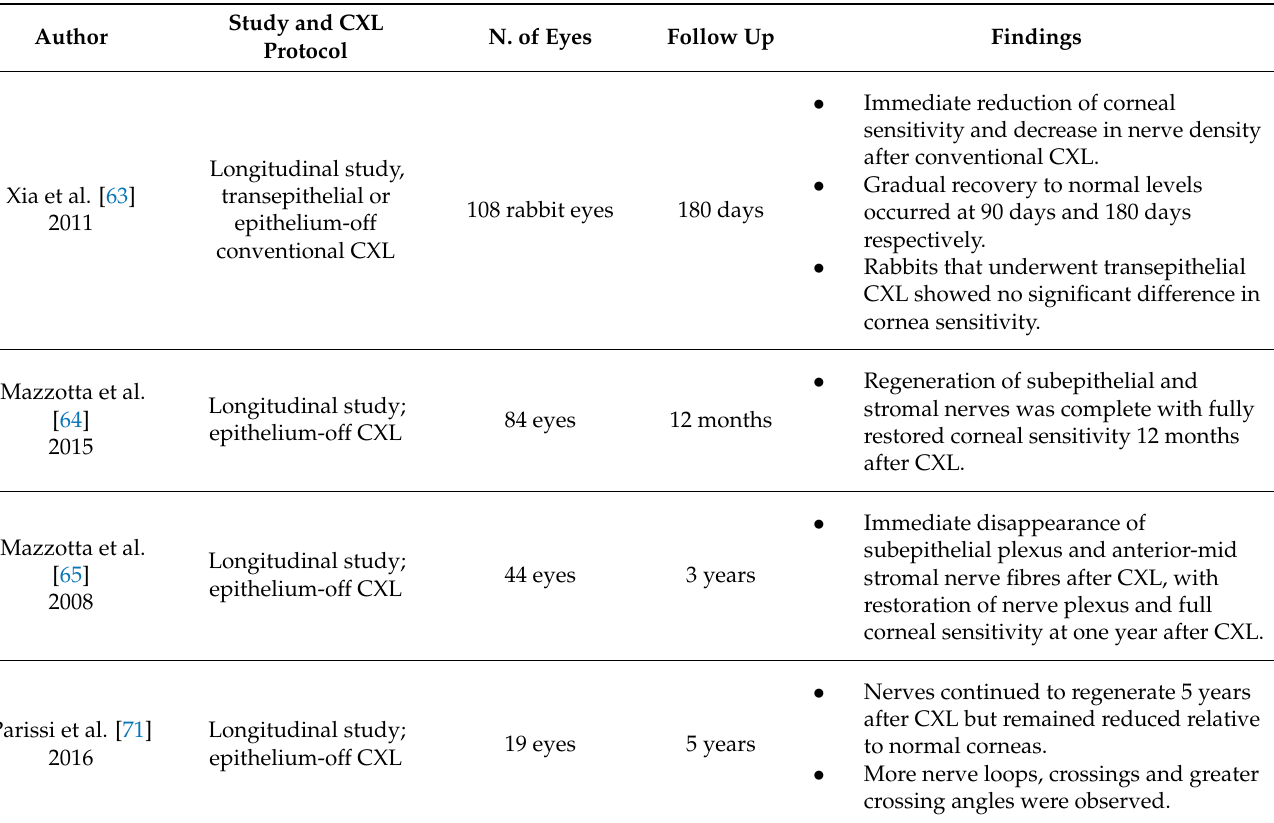
Table 2. Results of main studies investigating corneal cell and nerve alternations after CXL in